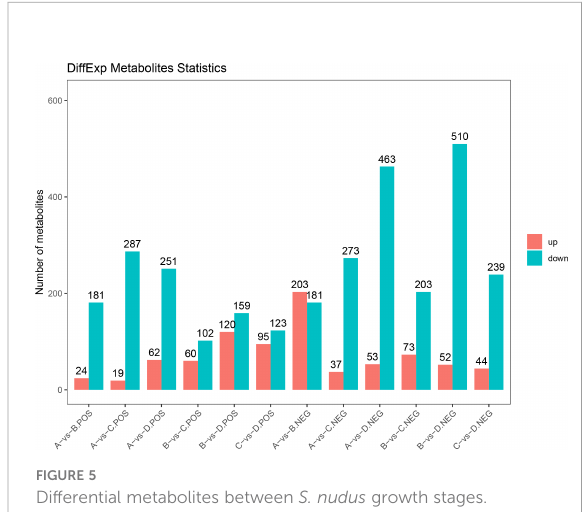
FIGURE 5 Differential metabolites between S. nudus growth stages. (A, B, C, D) represent four developmental stages of S. nudus : larve, one-quarter of adult, half of adult and adult, respectively.